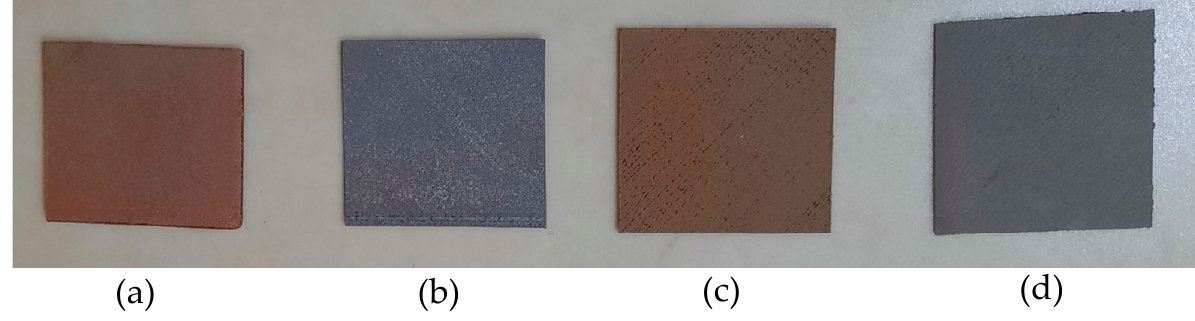
Figure 4. Four types of 3D printed samples: ( a ) Cu/PLA; ( b ) SS 17-4/PLA; ( c ) CuSn/PLA; ( d ) Al 6061/PLA.